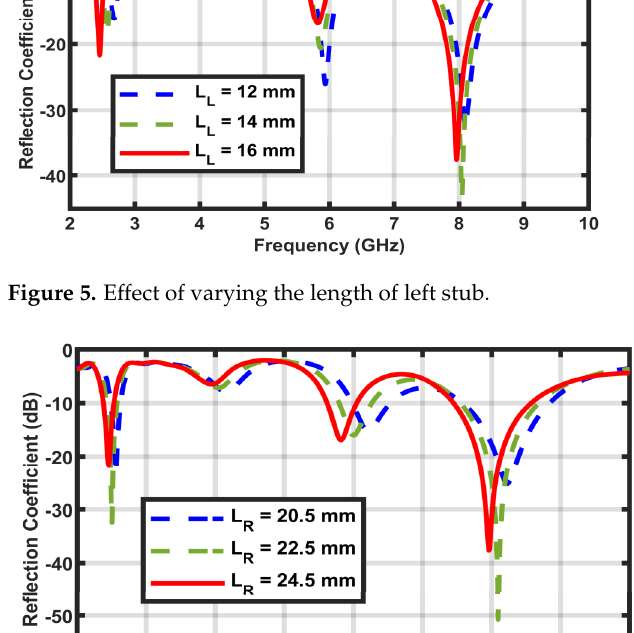
Figure 6. Effect of varying the length of the right stub.